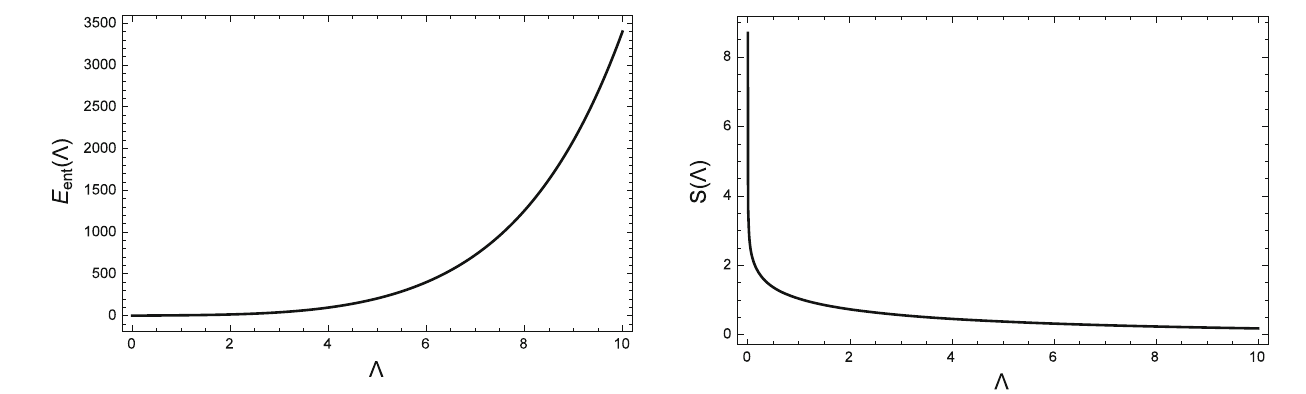
Fig. 2 The energy of entanglement E ent against the cosmological con- stant Λ . The quantity E ent is a monotonically growing function of the cosmological constant Λ and it vanishes for Λ = 0